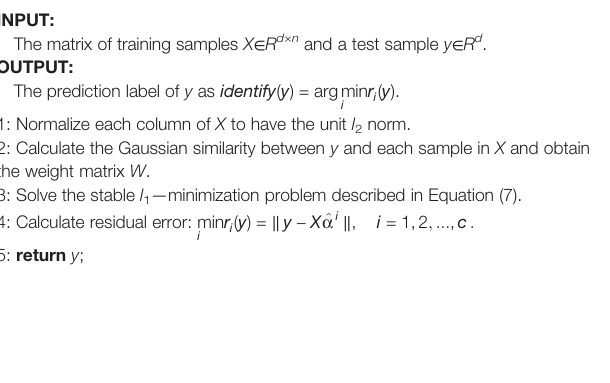
ALGORITHM 1 | Weighted sparse representation based classi fi cation